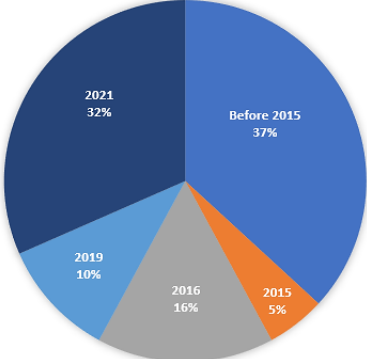
Figure 3. Distribution of the publications from 2015 to 2021 according to Scopus search results.